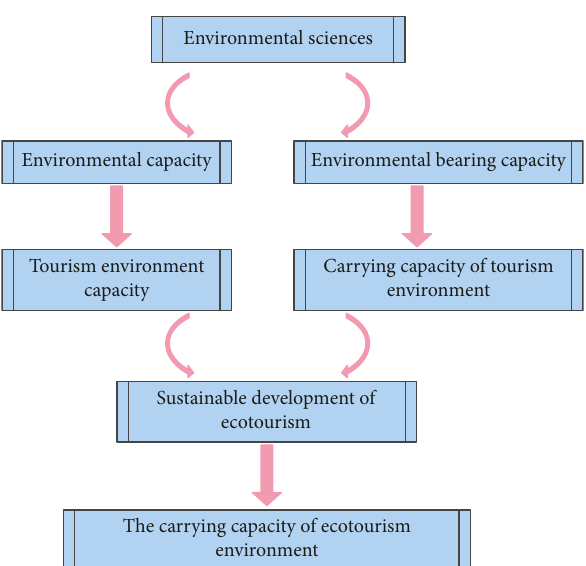
Figure 1: The relationship between the carrying capacity of eco- tourism, the carrying capacity of the tourism environment, and the capacity of the tourism environment.